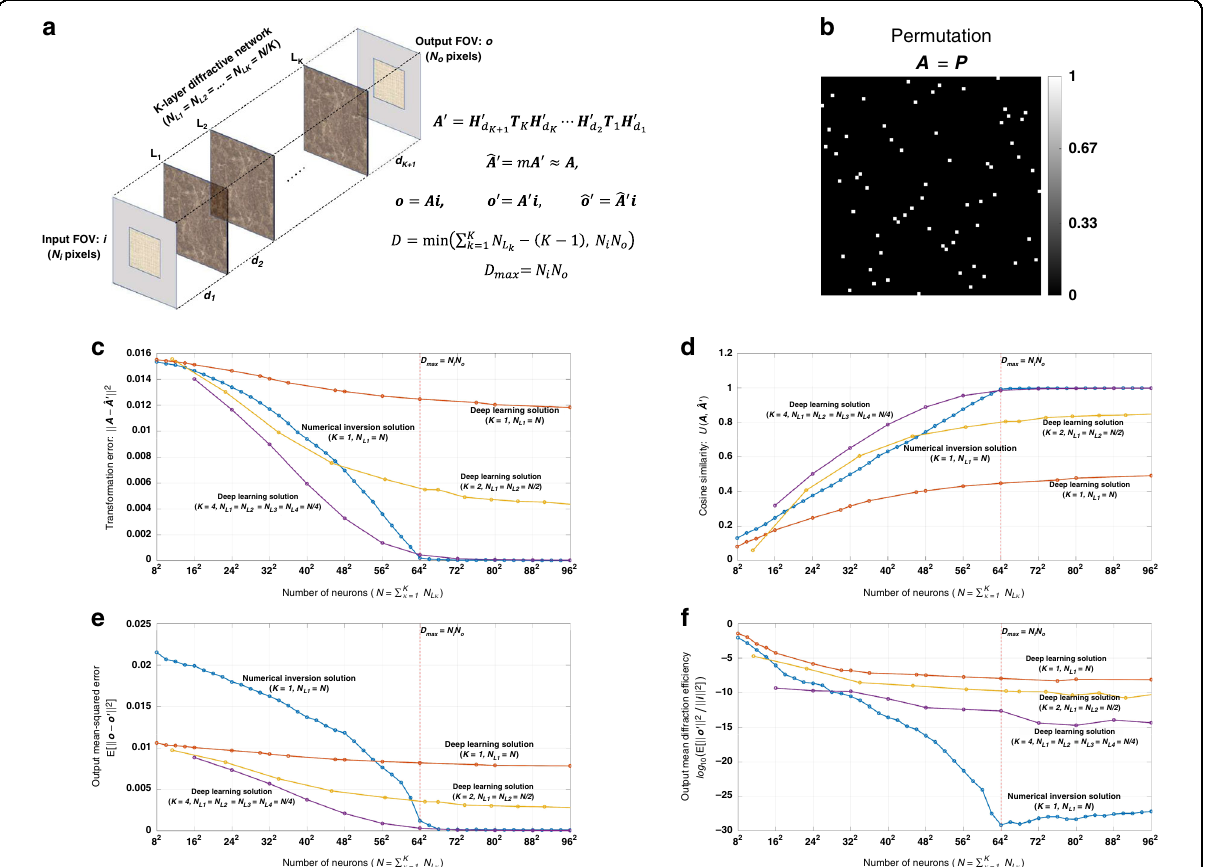
Fig. 10 Diffractive all-optical transformation results for a permutation operation. a Schematic of a K-layer diffractive network, that all-optically performs a linear transformation between the input and output fi elds-of-views that have N i and N o pixels, respectively. The all-optical transformation matrix due to the diffractive layer(s) is given by A ′ . b . Real and binary-valued ground truth (target) input-output transformation matrix, corresponding to a permutation operation. c All-optical transformation errors (see Eq. 5). The x -axis of the fi gure shows the total number of neurons ( N ) in a K-layered diffractive network, where each diffractive layer includes N / K neurons. Therefore, for each point on the x-axis, the comparison among different diffractive designs (colored curves) is fair as each diffractive design has the same total number of neurons available. The simulation data points are shown with dots and the space between the dots are linearly interpolated. d Cosine similarity between the vectorized form of the target transformation matrix in ( b ) and the resulting all-optical transforms (see Eq. 16). e Output MSE between the ground-truth output fi elds and the estimated output fi elds by the diffractive network (see Eq. 18). f The diffraction ef fi ciency of the designed diffractive networks (see Eq.